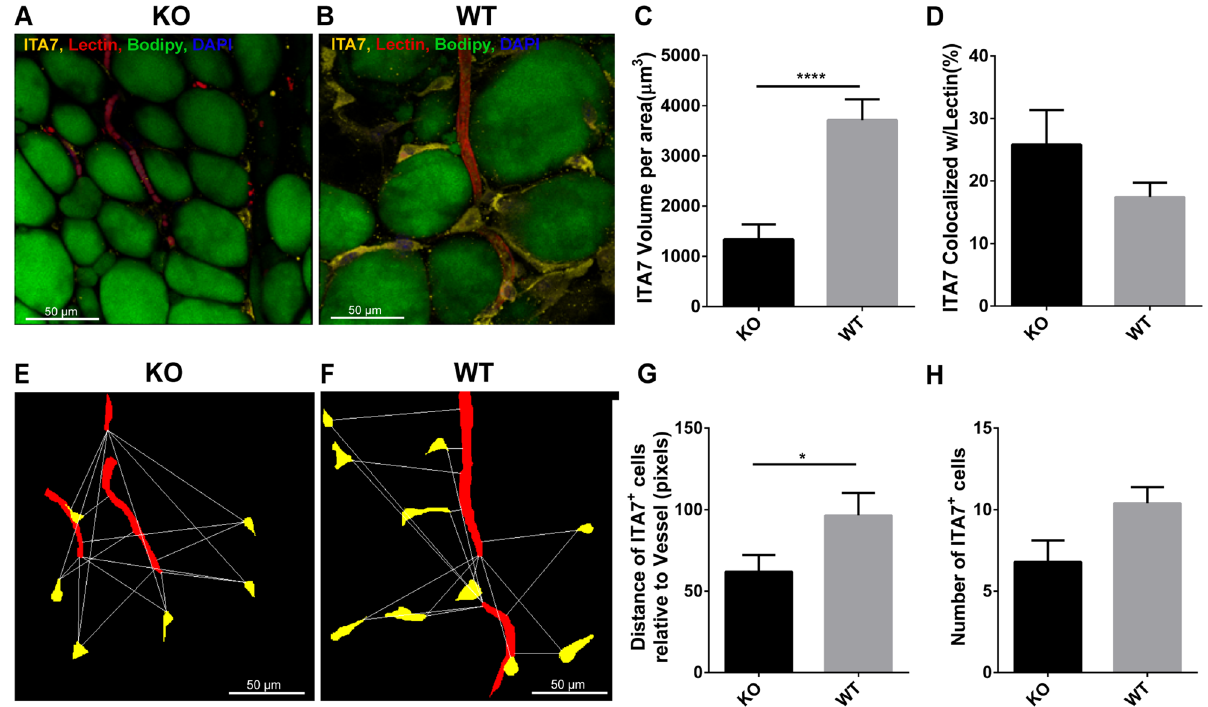
Figure 5. Analysis of ITA7 levels and spatial distribution in KO and WT adipose tissue. Immunohistochemical confocal images of fixed adipose tissue from ( A ) KO mice and ( B ) WT mice. Formaldehyde-fixed tissues were stained with antibodies against ITA7. Endothelial cells were counterstained with isolectin (red), the fatty acid with BODIPY (green) and the nucleus with DAPI (blue). ( C ) ITA7 volume was 64% lower in KO tissue compared to WT (1338 ± 296 μm 3 in KO vs. 37,013 ± 409 μm 3 in WT, p < 0.0001). ( D ) There is not significant difference in the percent of ITA7 colocalized with endothelial cells between KO and WT adipose tissue ( p = 0.17). Values are mean ± standard error from unpaired t test with Welch’s correction. Two tailed p value was calculated. n = 30 images from 4 WT animals and 25 images from 3 KO animals. ( E , F ) Representative masks of the images used to quantify the spatial proximity of ITA7 + cells with vessels of KO and WT adipose tissue. cytoNet analysis showed that ( G ) ITA7 + cells were closer to vessels in KO tissue compared to WT tissue (61.9 ± 14.6 pixels in KO vs. 96.5 ± 11.8 pixels in WT, p = 0.046), and ( H ) the number of ITA7 + cells was greater in WT tissue compared to KO, although this difference did not reach significance (6.8 ± 1.1 cells in KO vs 10.4 ± 1.1 cells in WT, p =